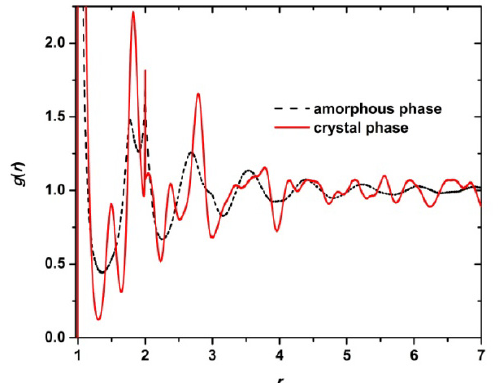
Figure 13. Total pair radial distribution function, , as a function of radial distance, r , in the initial amorphous and the final crystal phases as obtained from MC simulations on the N = 12 chain system with uniform length distribution at φ =